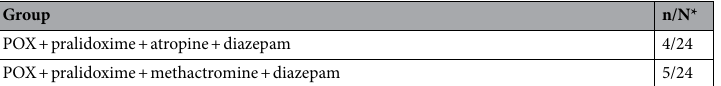
Table 3. Replacement of atropine on methoctramine in the “cocktail” used for the treatment of mice poisoned by 3xLD 50 of POX. * n number of mice survival 120 h after POX poisoning. N total number of mice in the group. POX—0.63 mg/kg, i.p. Composition of the “cocktail”: pralidoxime (30 mg/kg, i.p.), atropine (15 mg/ kg, i.p.) or methoctramine (8 mg/kg, i.p), diazepam (2 mg/kg, i.p.). Components of “cocktail” were i.p. administrated within 1 min after